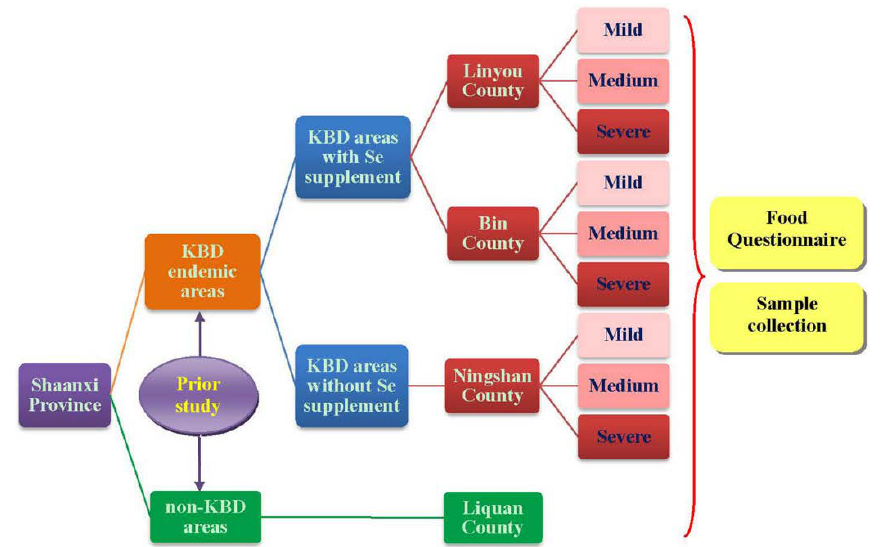
Figure 1. This diagram shows the study design including the stratified random sampling process and the contents of the